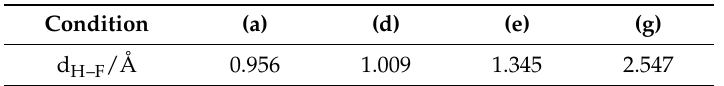
Table 2. Geometrical parameters of H 2 O molecule on Cu (111) surface in Figure 2.